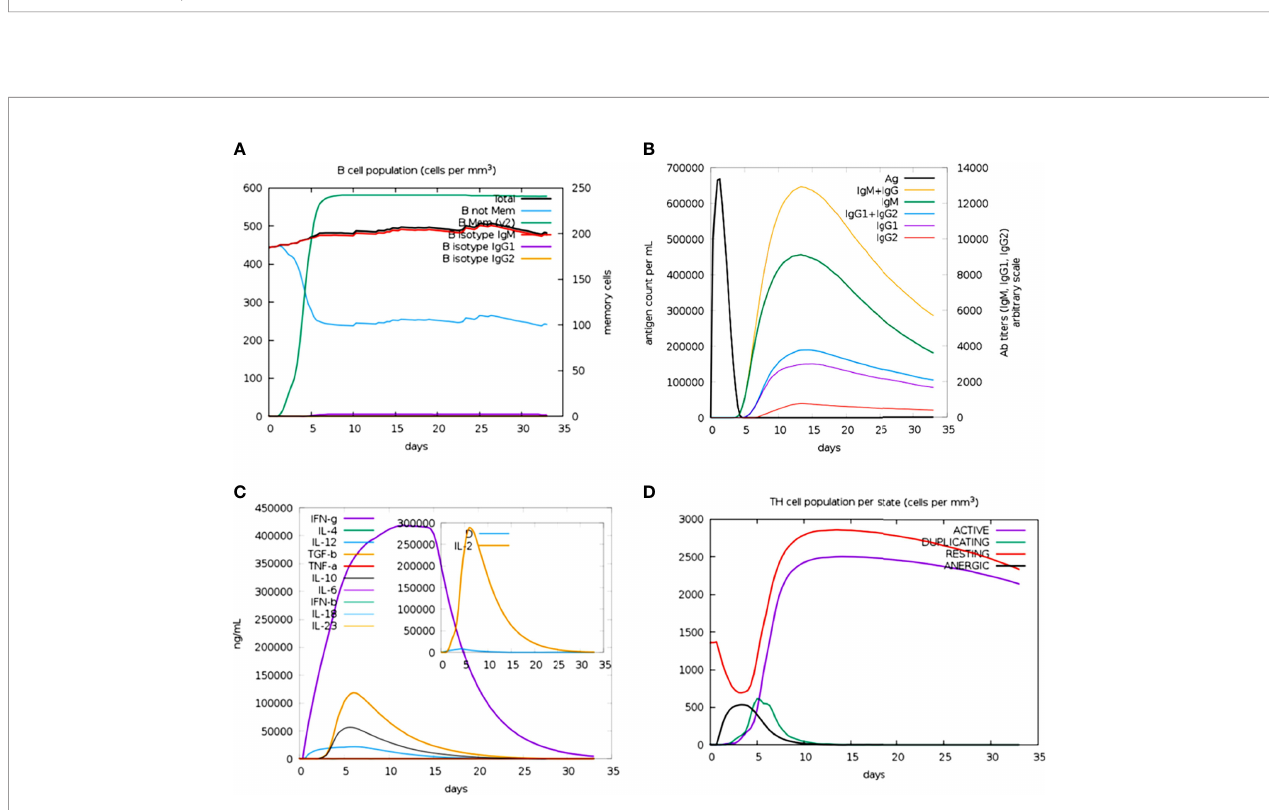
FIGURE 7 | Prediction of immune response against the generated chimeric construct. (A) Total B-cell responses. (B) Total antibody responses. (C) Interleukin responses. (D) Total T-cell responses.